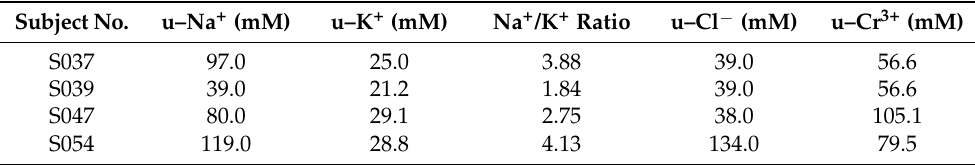
Table 1. The ion concentrations (Na + , K + , Cl − , and Cr 3+ ) and Na + /K + ratio in patient urine samples. Subject